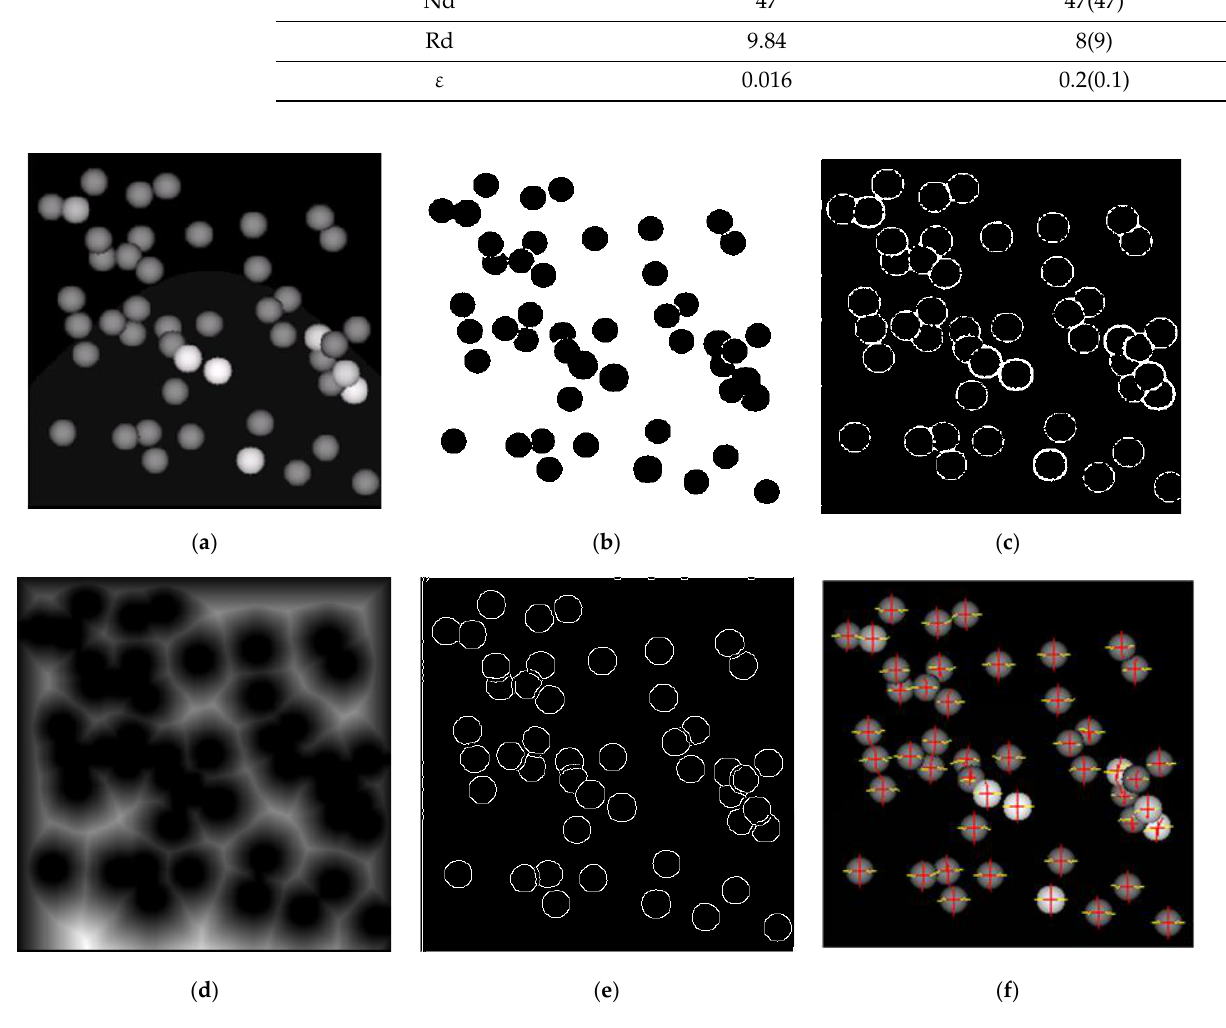
Figure 6. Comparative results of the segmentation on test image: ( a ) the initialimage (the scale according to Figure 3a), containing 47 particles with a radius of 10 pixels; ( b ) segmentation by Otsu’s method; ( c ) segmentation with the use of the adaptive threshold technique; ( d ) segmentation by Watershed method; ( e ) segmentation by Canny method; ( f ) the centres of the particles, and the zones of maximum curvature, obtained using a curvature